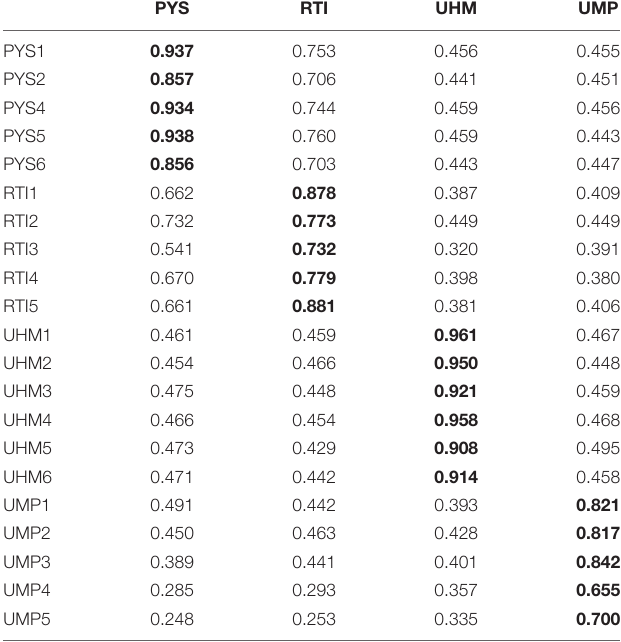
Bold values are main finding.